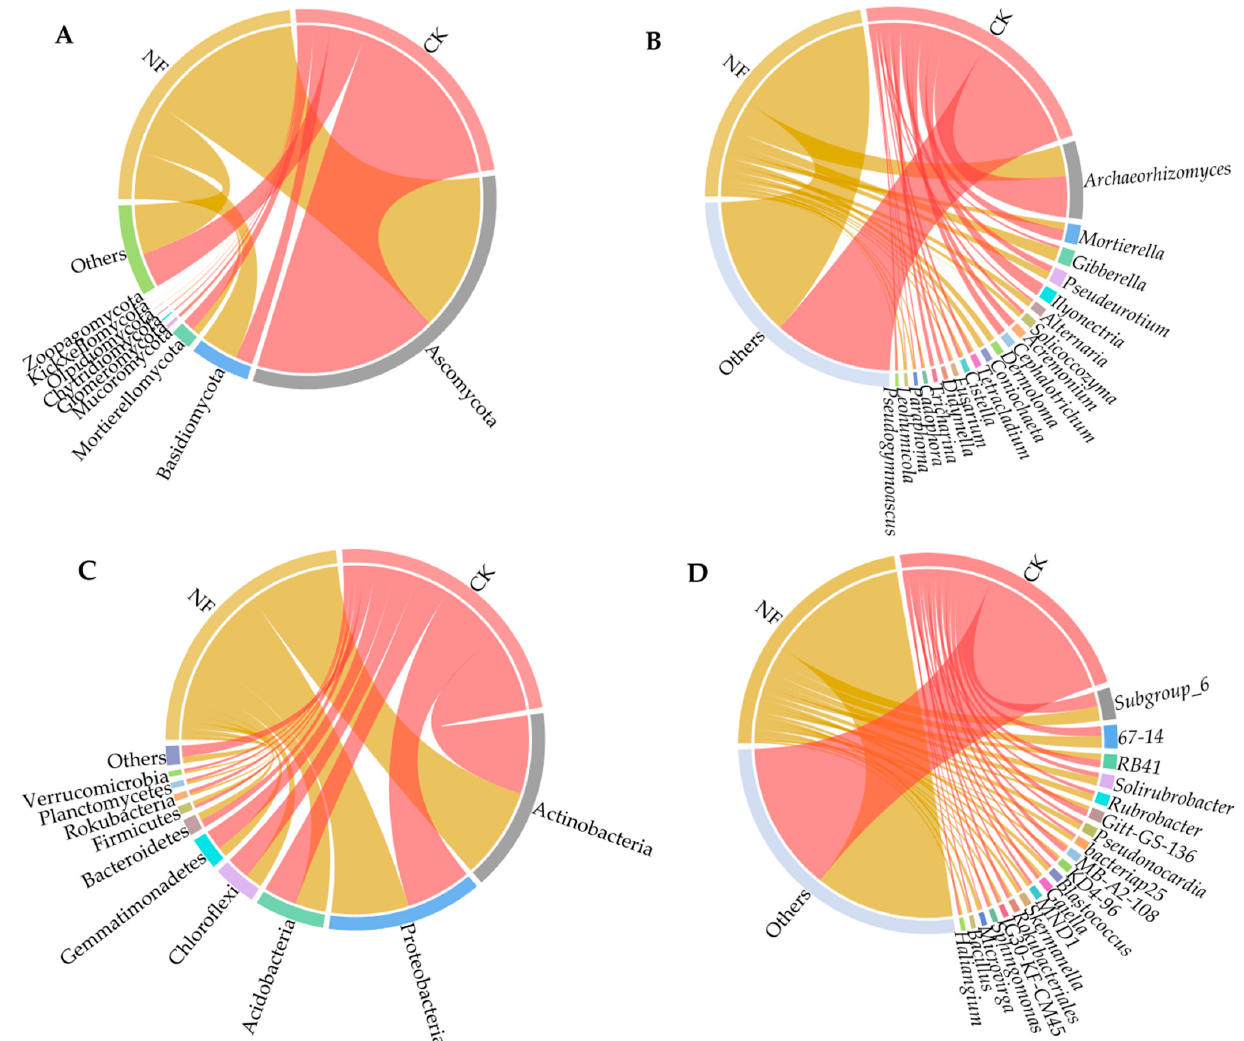
Figure 1. The distribution of abundant taxa with relative abundances > 1% in at least one sample. ( A ), Soil fungal community at phylum level; ( B ), Soil fungal community at genus level; ( C ), soil bacterial community at phylum level; ( D ), soil bacterial community at the genus level. NF: no-tillage reseeding and fertilization. CK: control check.